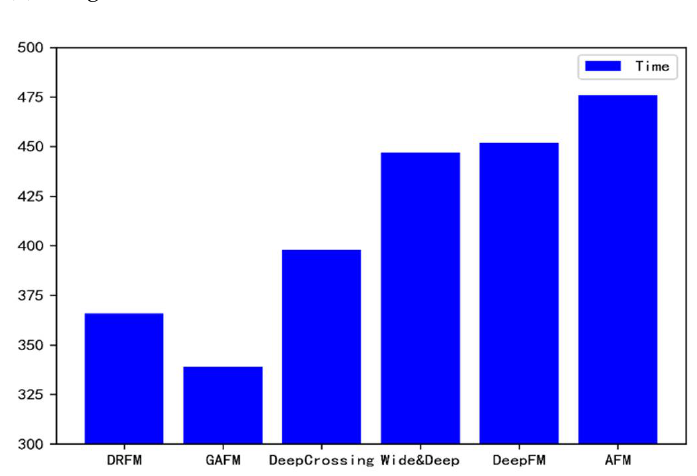
Figure 11. Running time of each model on dataset